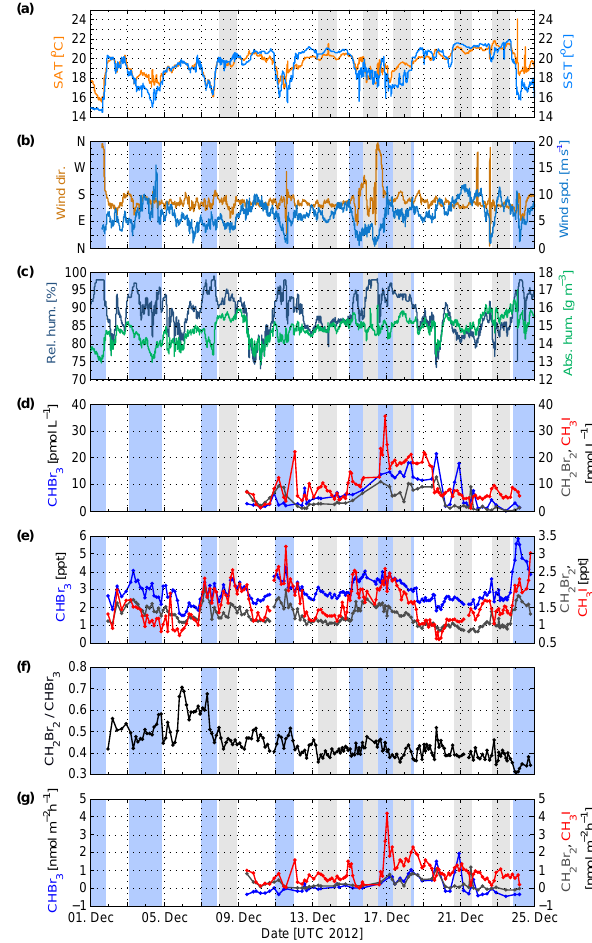
Figure 3. Observations during 1–25 December 2012 on R/V ME- TEOR . Diurnal stations are indicated by grey background shading. (a) 10min mean of the SAT (orange) and the SST (blue) in ◦ C. Ac- cording to SST decrease, upwelling regions are marked with light- blue background shading in (b–e) . (b) 10min mean of wind direc- tion in cardinal directions (ochre) and wind speed in ms − 1 (blue). (c) 10min mean of relative humidity in % (dark blue) and absolute humidity in gm − 3 (green). (d) Oceanic surface concentrations of bromoform (CHBr 3 , blue), dibromomethane (CH 2 Br 2 , dark grey) and methyl iodide (CH 3 I, red) in pmolL − 1 . (e) Atmospheric mix- ing ratios of bromoform, dibromomethane and methyl iodide in ppt. (f) Concentration ratio of atmospheric dibromomethane and bromo- form. (g) Sea–air flux for bromoform, dibromomethane and methyl iodide in nmolm − 2 h − 1